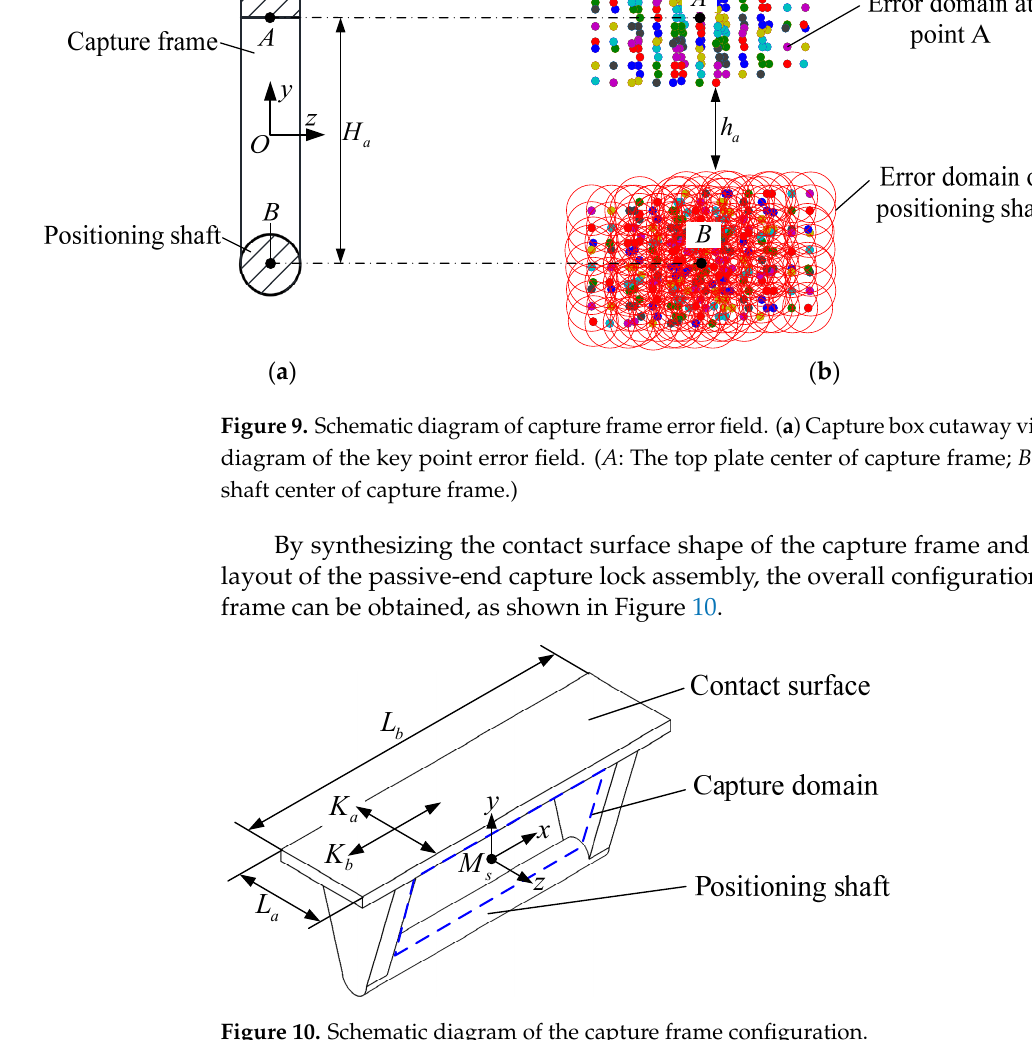
Figure 9. Schematic diagram of capture frame error field. ( a ) Capture box cutaway view; ( b ) sche- matic diagram of the key point error field. ( A : The top plate center of capture frame; B : The posi- tioning shaft center of capture frame.)